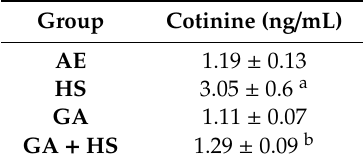
Table 3. Urine cotinine level of mice exposed to air (AE) or hookah smoke (HS) with or without GA treatment.